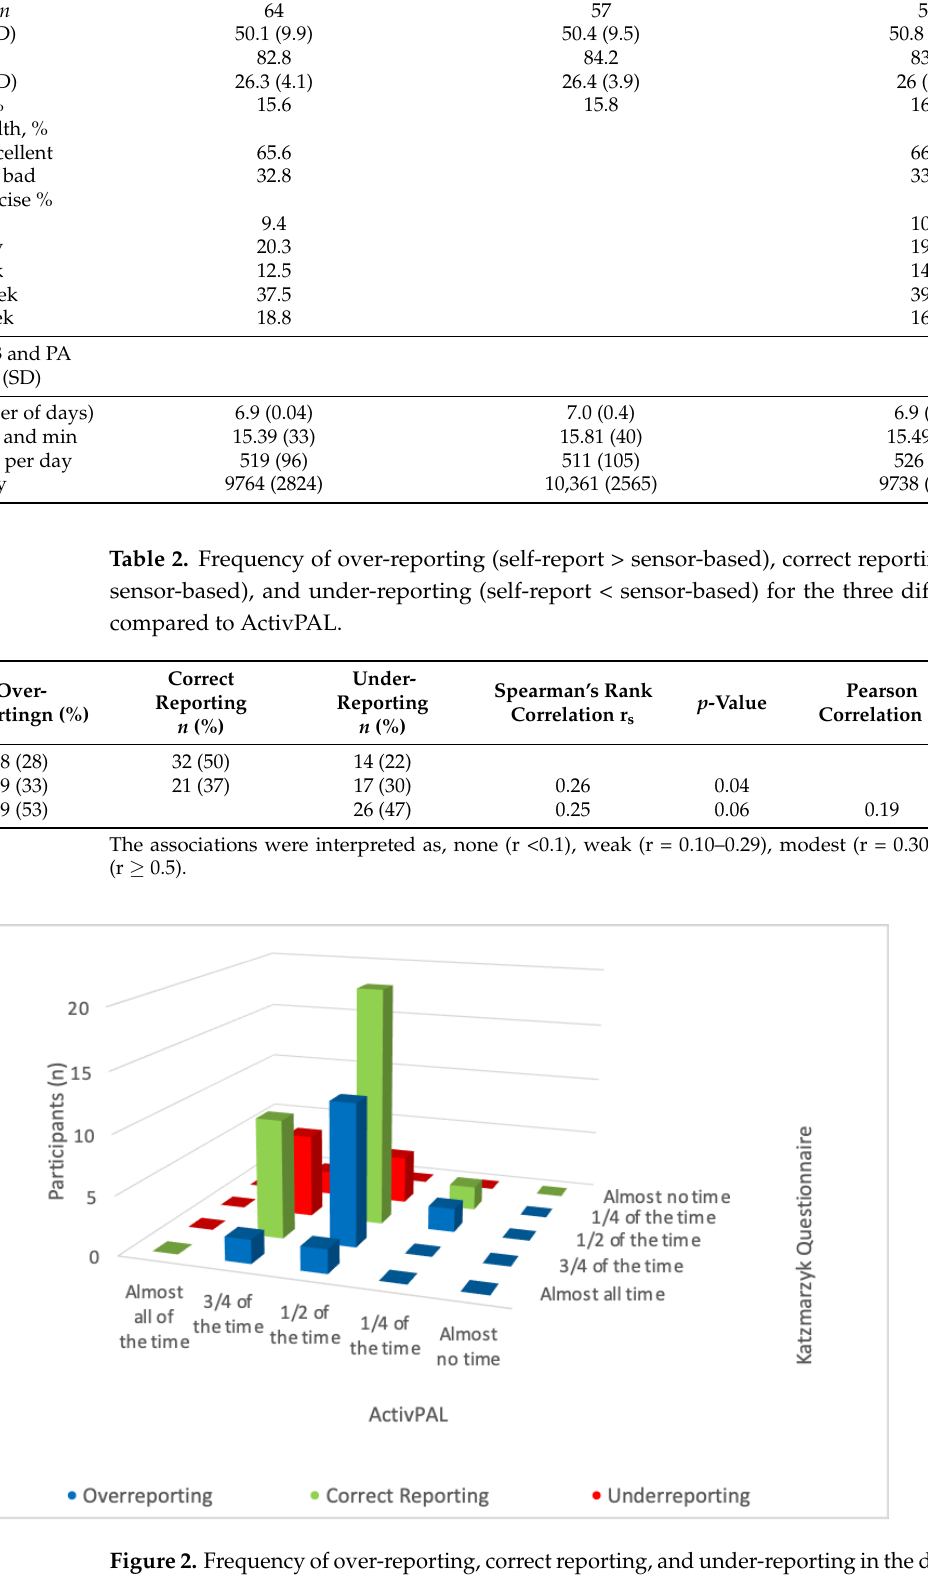
Figure 3. Frequency of over-reporting, correct reporting, and under-reporting in the different re- sponse categories for SED-GIH compared with ActivPAL.